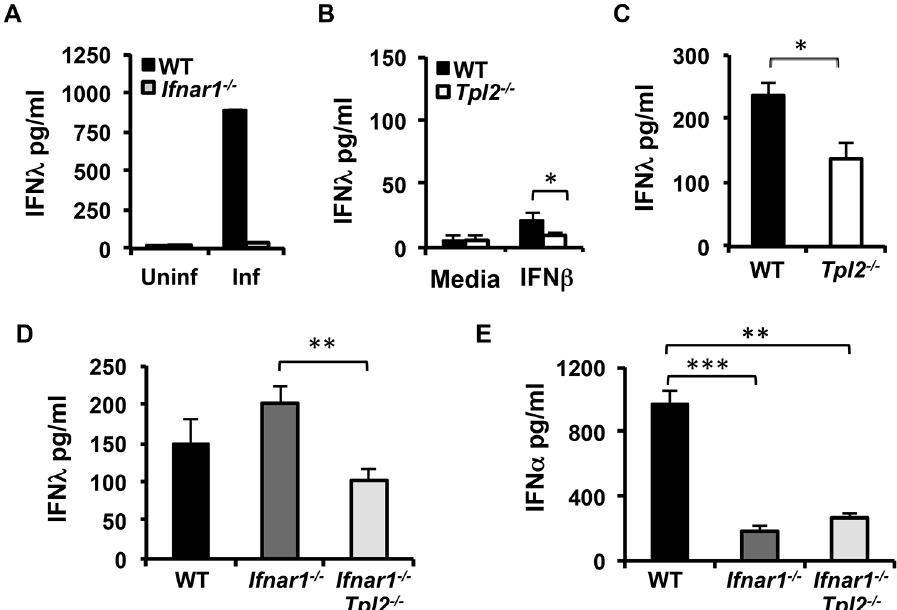
Fig 5. IFN λ production is IFNAR-independent in influenza virus-infected lungs. (A) Flt3 ligand-derived DCs from WT and Ifnar1 -/- mice were infected with WSN virus for 24 hr, and IFN λ secretion was measured by ELISA. (B) Flt3 ligand-derived DCs from WT and Tpl2 -/- mice were treated with IFN β for 24 hr, and IFN λ secretion was quantitated by ELISA. Data are representative of 2 (A) or 3 (B) independent experiments. Graphs show means ± SD. (C) WT and Tpl2 -/- mice were infected with 10 4 pfu of X31 virus, and IFN λ levels in lung homogenates were measured by ELISA on D3 pi; n = 5 WT and 5 Tpl2 -/- mice. WT, Ifnar1 -/- and Ifnar1 -/- Tpl2 -/- mice were infected with 10 4 pfu of X31 virus, and IFN λ (D) and IFN α (E) levels in lung homogenates were measured by ELISA on D3 pi; n = 4 WT, 5 Ifnar1 -/- and 9 Ifnar1 -/- Tpl2 -/- mice. Graphs show means ± SEM. * indicates p < 0.05, ** indicates p < 0.01, *** indicates p <